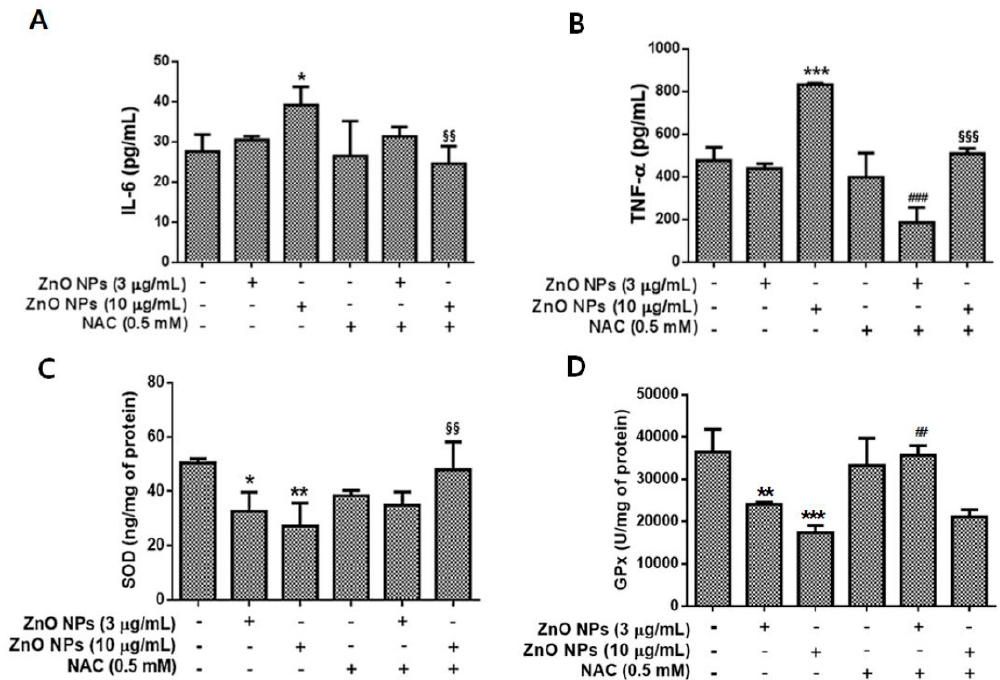
Figure 6. Effects of ZnO NPs on the pro-inflammatory cytokines interleukin (IL)-6 ( A ) and tumor necrosis factor (TNF)- α ( B ) and the antioxidant enzymes superoxide dismutase (SOD) ( C ) and glutathione peroxidase (GPx) ( D ) in primary cultured astrocyte cells. The levels of IL-6 and TNF- α were significantly elevated at 24 h following exposure to 10 μ g/mL of ZnO NPs compared with the control. NAC treatment (0.5 mM) restored the levels of IL-6 and TNF- α to that of the control. The levels of SOD and GPx were significantly decreased by ZnO NP treatment in a dose-dependent manner. Data represents the mean ± SEM. * p < 0.05, ** p < 0.01, *** p < 0.001 compared to the respective controls. ## p < 0.01 compared to 3 μ g/mL ZnO NPs; §§ p < 0.01, §§§ p < 0.001 compared to 10 μ g/mL of ZnO NPs ( n = 4).